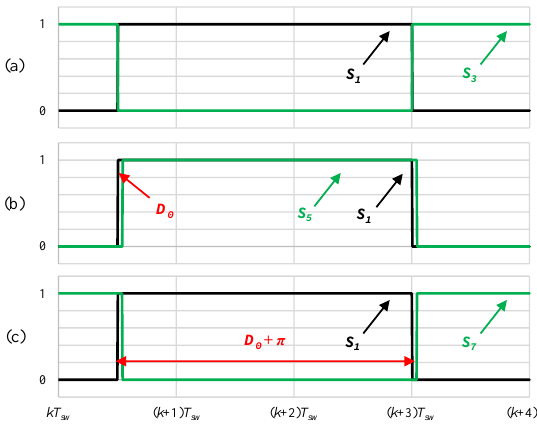
Figure 9. Triggering gate signals using